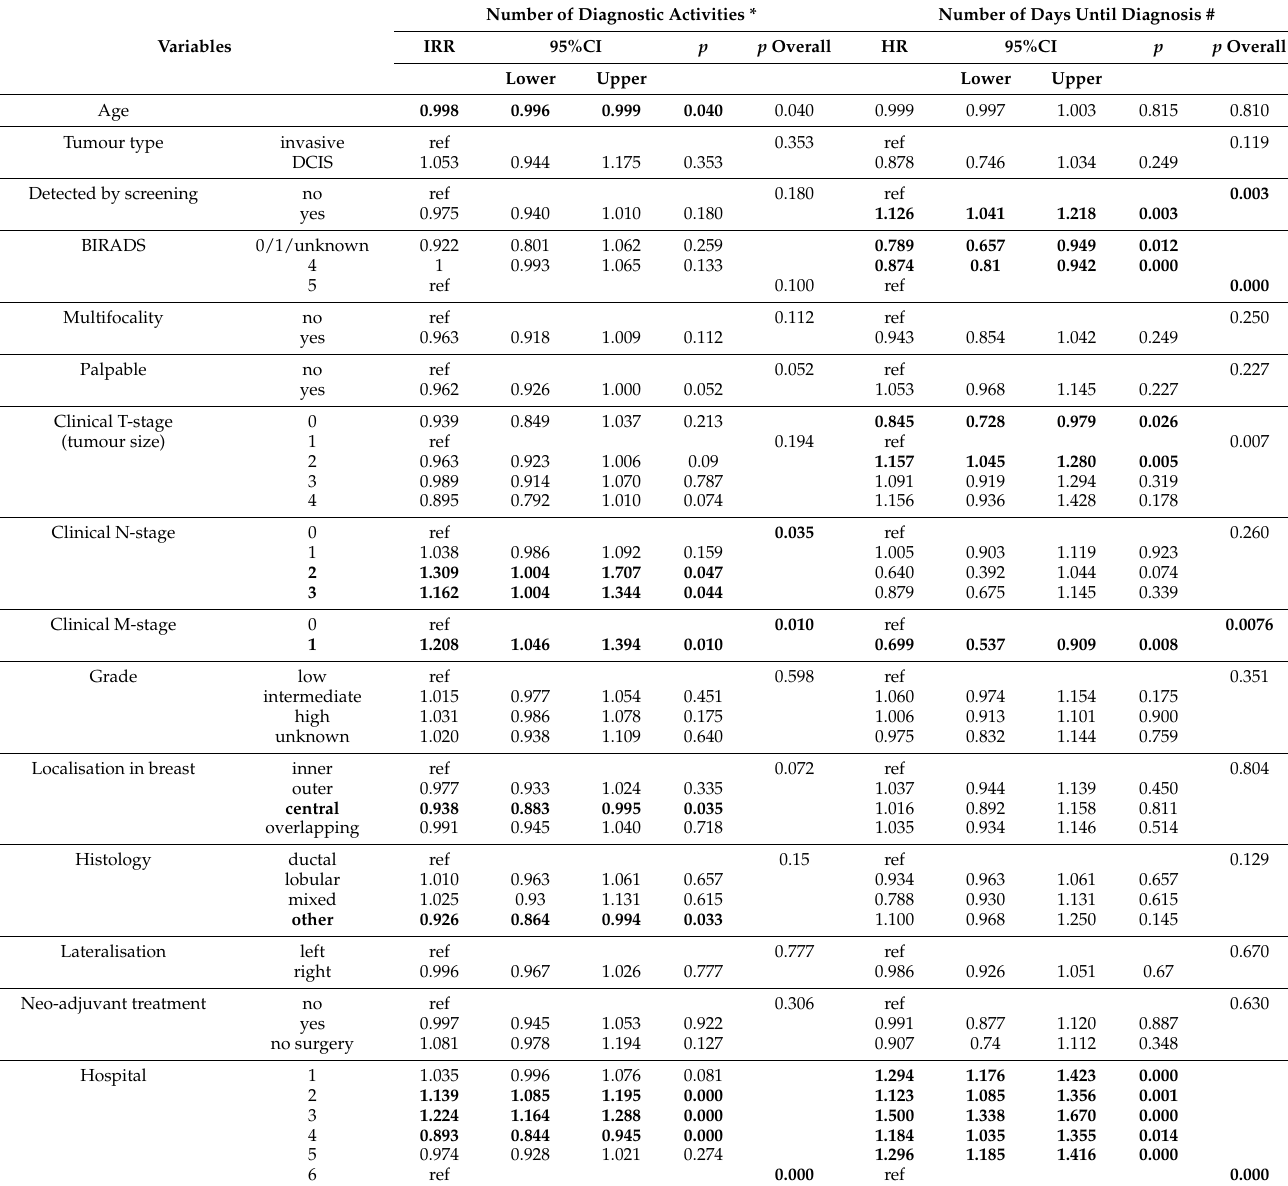
Table 1. Influencing factors on number of diagnostic activities (Poisson regression *) and on number of days until diagnosis (Cox regression #) performed in the malignant cohort (complete case analysis n =